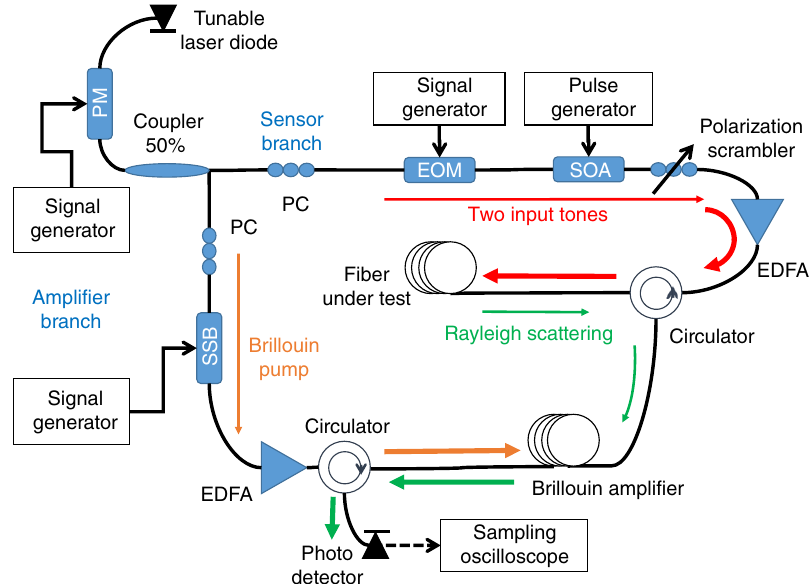
Fig. 8 Schematic illustration of the experimental setup. Light from a tuneable laser diode source at a central optical frequency ω 0 is used to generate all waveforms. An electro-optic phase modulator (PM) that is driven by a pseudo-random bit sequence is used to broaden the laser linewidth to the order of 100 MHz (broadening was only used in the experiments reported in Figs. 6, 7). Light in the sensor branch is modulated by an electro-optic amplitude Ω within a common pulse envelope. modulator (EOM) and a semiconductor optical ampli fi er (SOA), to generate two tones at optical frequencies ω 0 ± 1 2 The input waveform (red) is ampli fi ed by an erbium-doped fi bre ampli fi er (EDFA) and launched into one end of a fi bre under test. The two- fi eld components are coupled by a forward stimulated Brillouin scattering process along the fi bre, which strongly depends on the choice of the radio-frequency difference Ω . Rayleigh back-scatter (green) of the two tones propagates back through a fi bre-optic circulator into a second fi bre section, which is used as a frequency-selective, backwards stimulated Brillouin scattering (SBS) ampli fi er. Light from the laser diode source in the ampli fi er branch (brown) is offset in frequency by a single-sideband electro-optic modulator (SSB), to generate the SBS pump wave. The SBS ampli fi cation is tuned to separate between the Rayleigh back-scatter contributions of the two optical tones. The ampli fi ed waveforms are detected by a photo-detector and sampled by a real-time oscilloscope for further off-line processing. Measurements are repeated for multiple choices of Ω . The analysis of the collected Rayleigh back-scatter traces generates optomechanical time-domain re fl ectometry maps for distributed sensing of media outside the cladding (and even outside the coating) of the fi bre under test. PC polarization